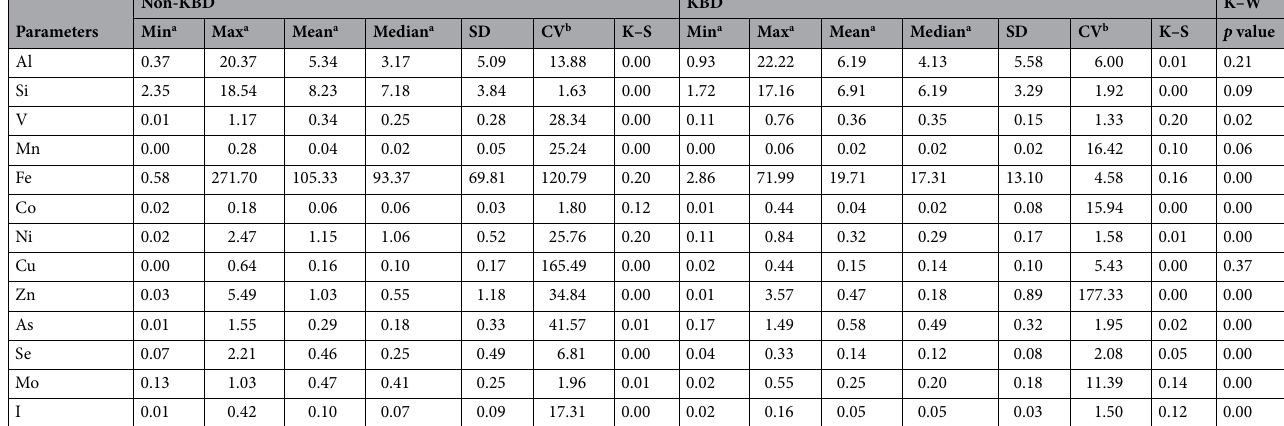
Table 2. Summarized data for trace elements in surface waters from the non-KBD and KBD endemic areas in the Longzi County. a Concentrations data are in μg L −1 . b Coefficient of variation